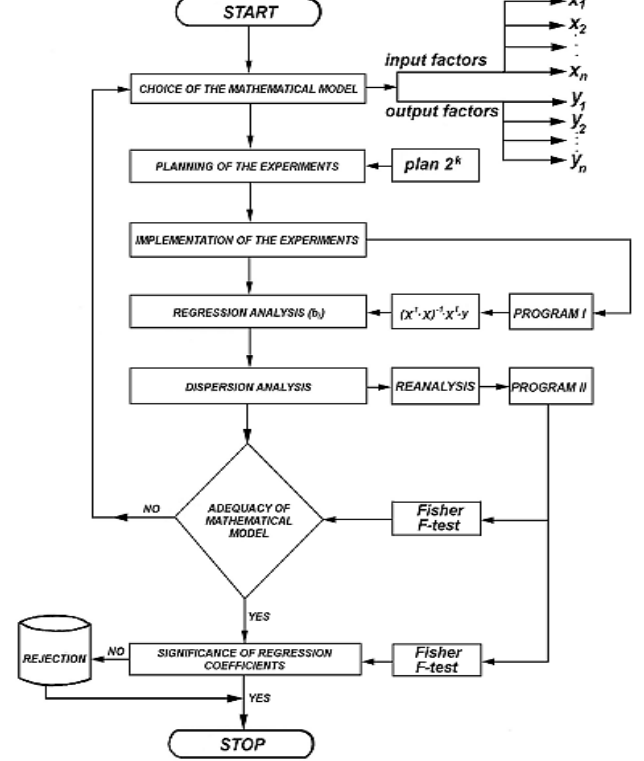
Figure 3. Methodology of realization of